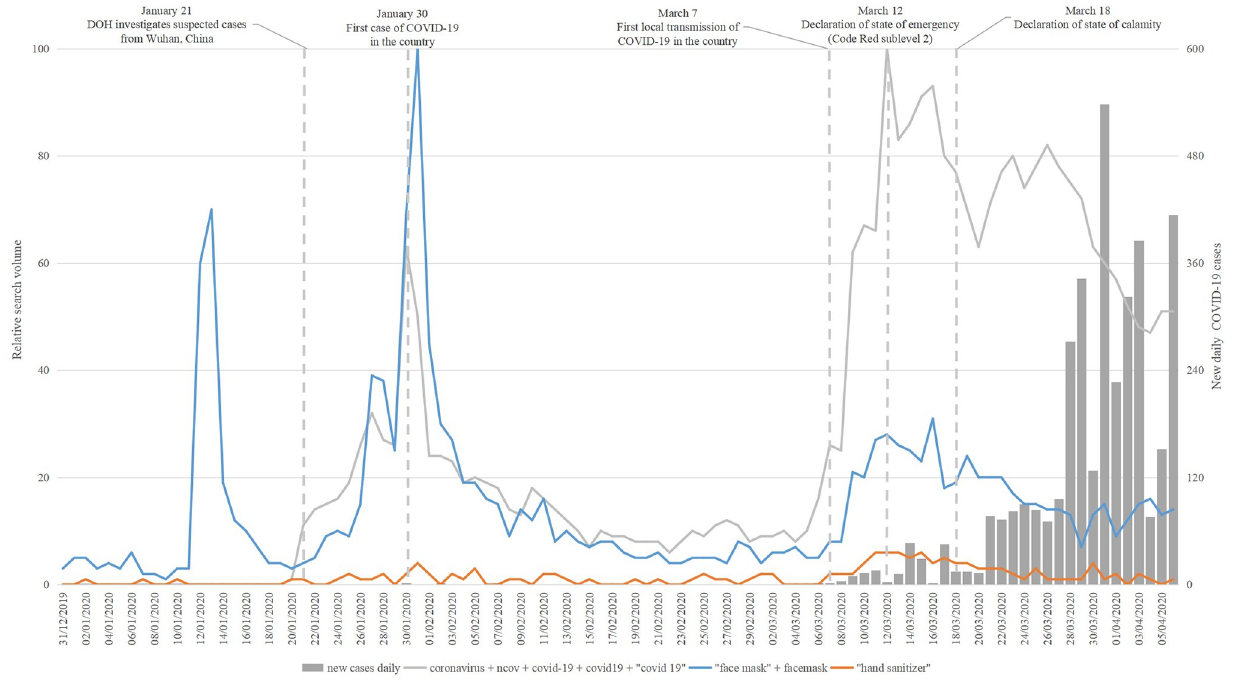
Fig 2. Search interests for personal protective